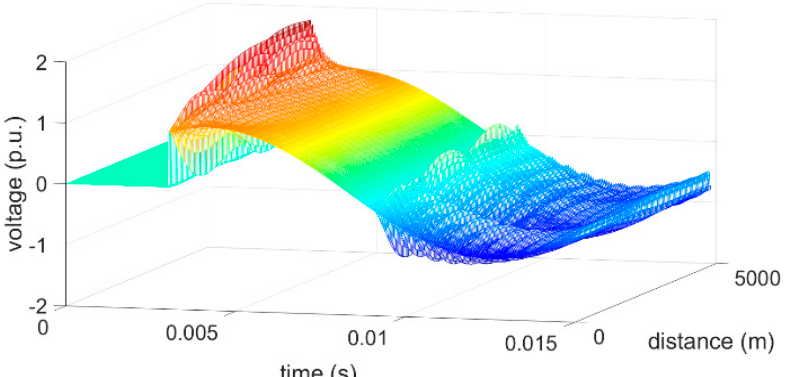
Figure 10. Voltage profile computed along phase A (example 3.2).